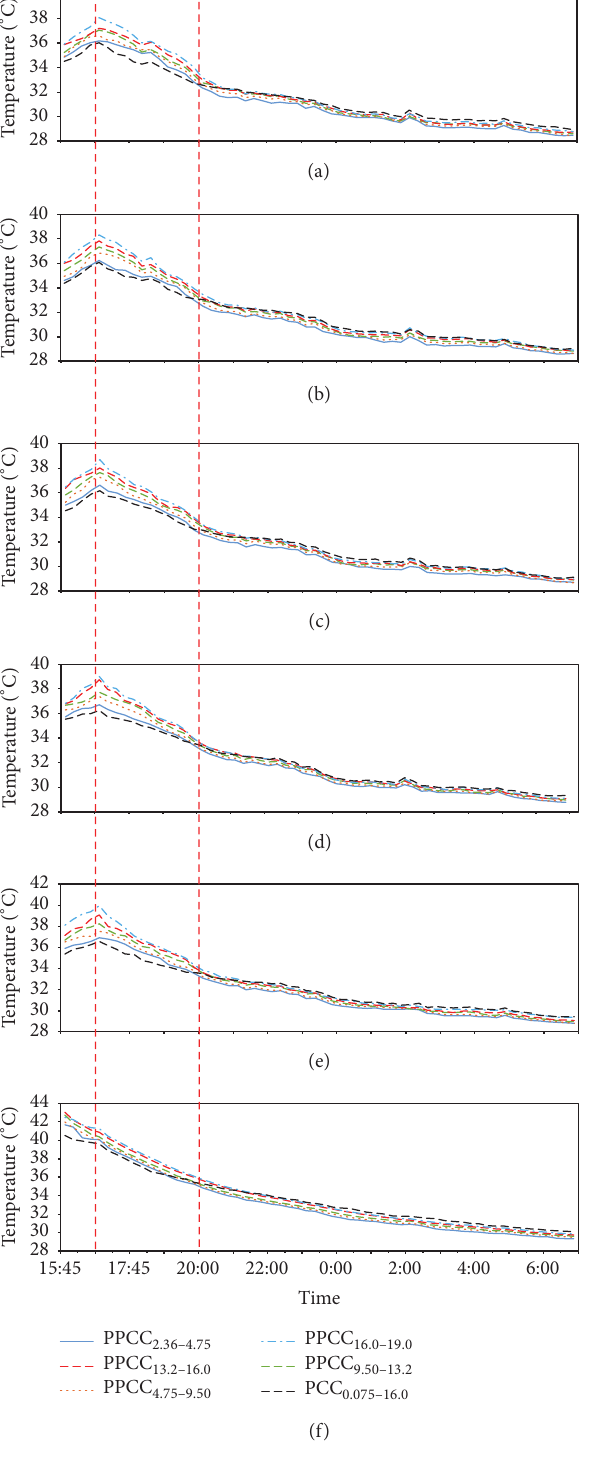
Figure 8: The curves of surface temperature and near-surface air temperature: (a) 130 cm; (b) 100cm; (c) 75 cm; (d) 50cm; (e) 25 cm; (f) 0